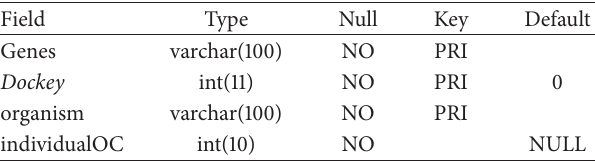
Table 4: Generic genes table description.